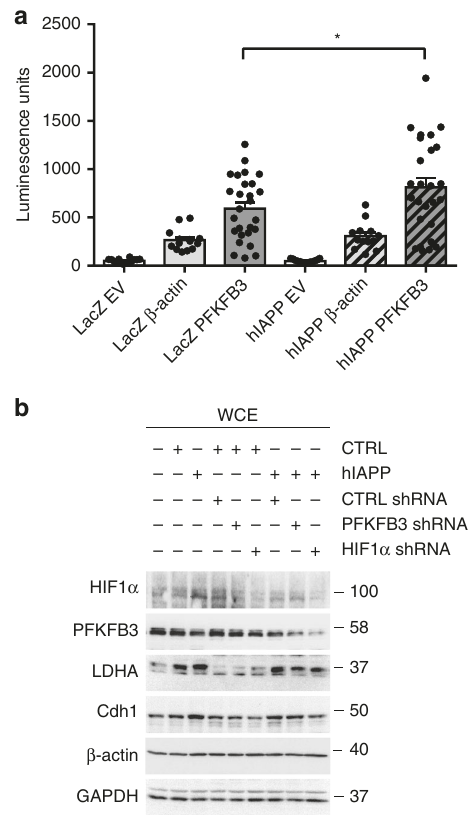
Fig. 3 HIF1 α drives the expression of PFKFB3 in β -cells. a Luciferase assay showing the activation of PFKFB3 promoter containing 2 hypoxia elements. INS 832/13 overexpressing LacZ or hIAPP were transfected for 36 h with plasmid vectors containing: RenSP luciferase gene without a promoter (empty vector — EV) measuring the background signal or housekeeping gene promoter driving the expression of RenSP luciferase gene ( β -actin) or PFKFB3 promoter with hypoxia elements driving the expression of RenSP luciferase gene (PFKFB3). b Representative Western blot of HIF1 α , PFKFB3, LDHA, Cdh1 in whole cell extracts of INS 832/13 overexpressing LacZ (CTRL) or hIAPP, silenced or not with short hairpin RNA for PFKFB3 (PFKFB3 shRNA) and HIF1 α (HIF1 α shRNA) for 36 h. CTRL shRNA is non- target shRNA control vector. β -actin and GAPDH were used as loading control. Data are presented as mean ± SEM, n = 9 independent biological samples (in (a)). Statistical signi fi cance was analyzed by unpaired t -test (* p <